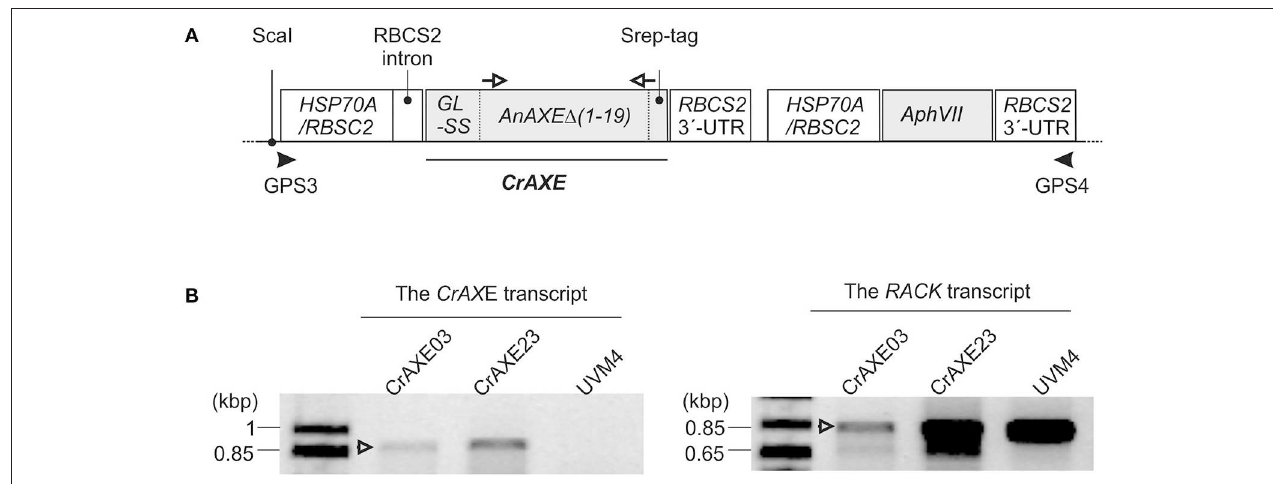
FIGURE 3 | Generation of C. reinhardtii transgenic strains expressing the CrAXE transcript. (A) Schematic illustrations of the gene constructs. The following non-translated genetic elements were included in order to enhance transcription and translation of the recombinant protein: the HSP70A/RBSC2 promoter, the RBCS2 intron, and the RBCS2 3 ′ UTR, as previously described in Ramos-Martinez et al. (2017). GL-SS indicates the signal sequence derived from gametolysin of C. reinhardtii as described in the afore-mentioned reference and is fused to the truncated AnAXE lacking its native signal sequence and a strep tag for detection of the recombinant protein. Primers used for genotyping by PCR and gene specific primers use for RT-PCR are shown by black arrowheads and open arrows, respectively. (B) An agarose gel electrophoretic analysis of RT-PCR products derived from the transgenic strains CrAXE03 and CrAXE23. The binding sites of oligonucleotide primers used for RT-PCR analysis are indicated as white arrows in panel A. The expected product size is 859 bp. As a loading control, amplification of a house-keeping gene, RACK , was performed.